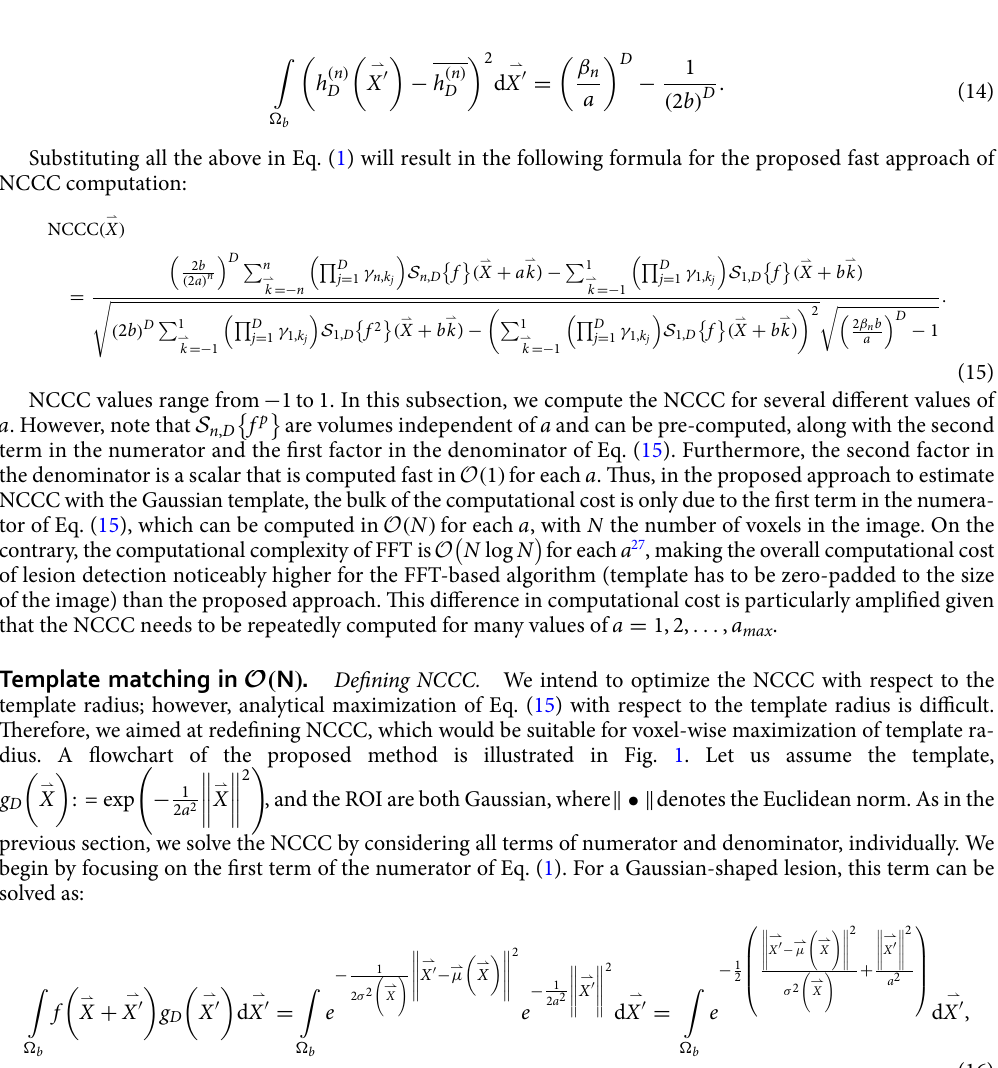
Figure 1. A flowchart depicting the proposed O ( N ) method. We first calculate a closed-form formula for the optimal radius by Gaussian modeling of the lesion, which we then apply to the local image statistics (estimated from a smoothed version of the MRI volume) to compute the optimal radius at each voxel. We then use an approximated Gaussian template (by consecutive convolutions with the boxcar kernel) to compute the NCCC at each voxel, from which we keep a pre-determined number of top detected